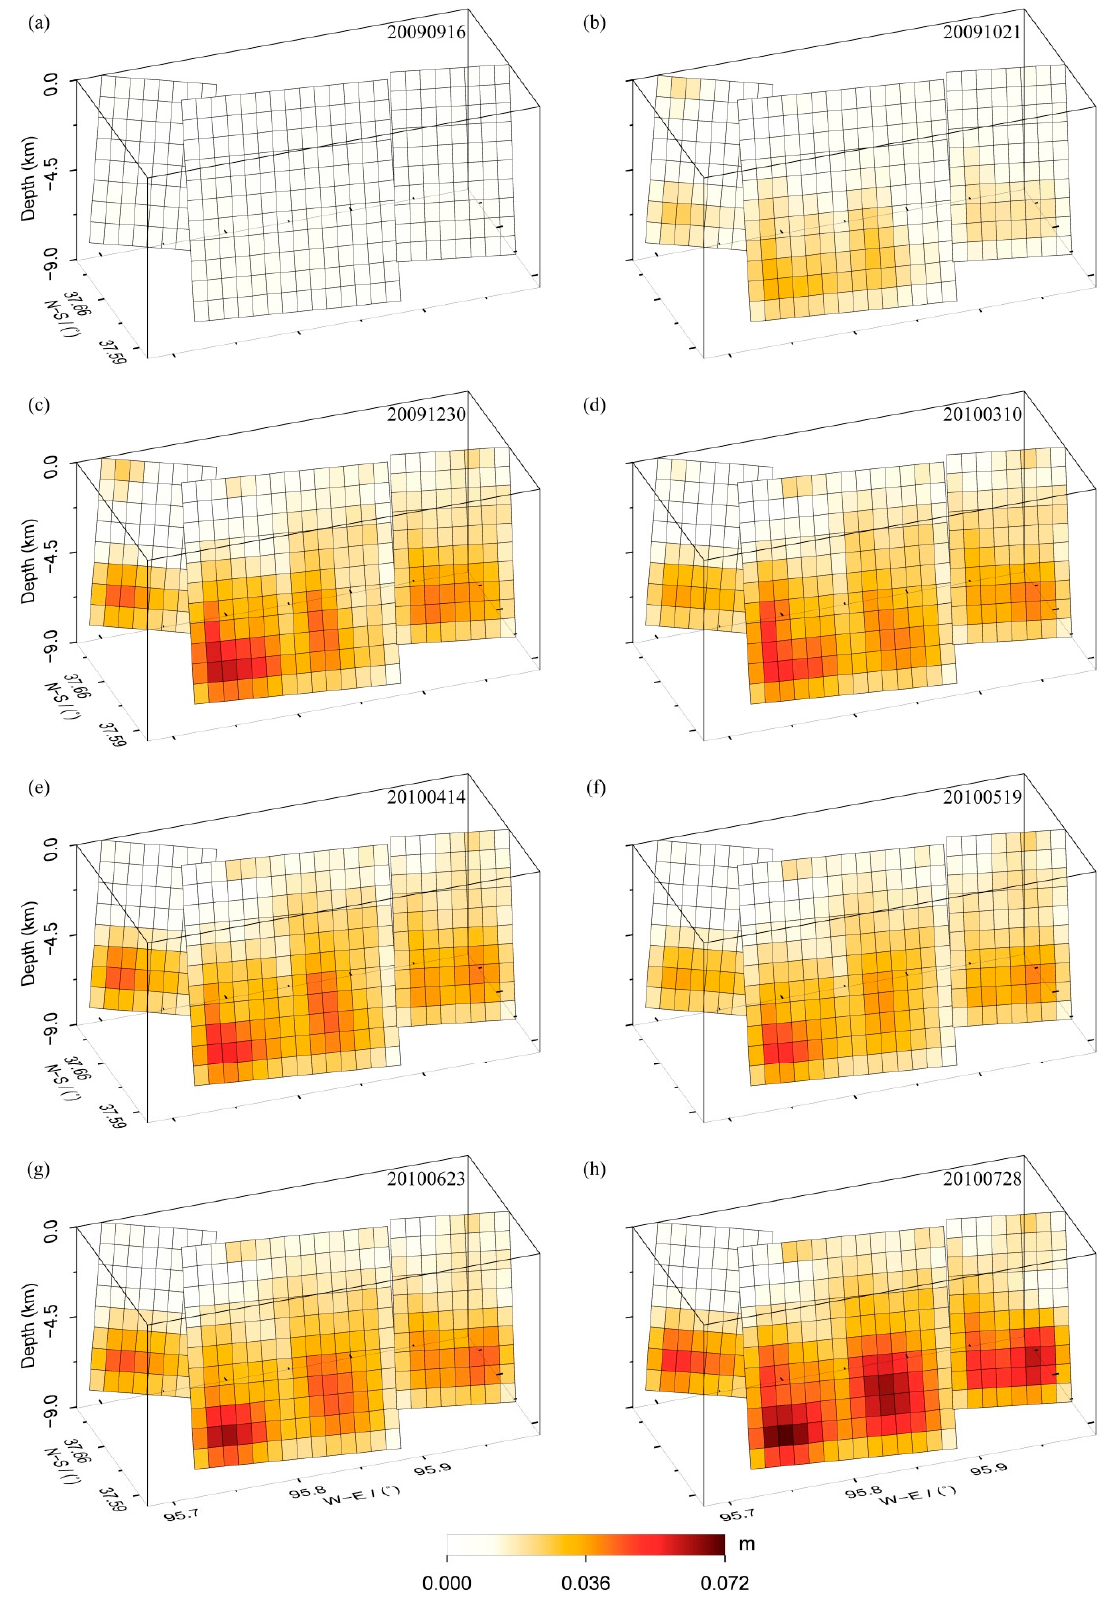
Figure 7. ( a – h ) Corresponding uncertainties for the afterslip models in Figure 6. These uncertainties for each date are estimated from the Monte Carlo calculation with 100 perturbed datasets, respectively.